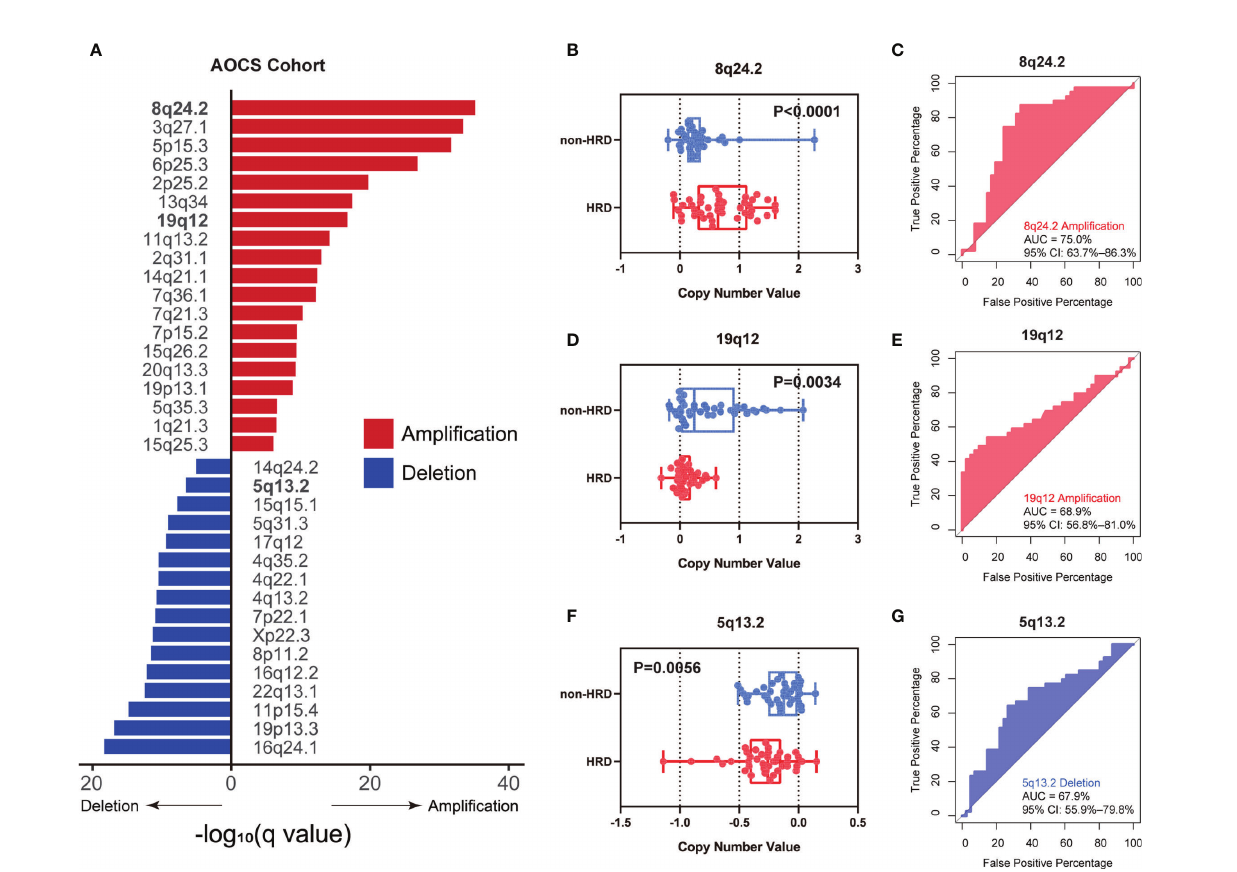
FIGURE 2 | External validation of the CNV biomarkers for HRD status in AOCS. (A) The enrichment level of genome CNVs in all ovarian cancer patients from the AOCS cohort. (B – G) According to BRCA1/2 mutation, BRCA1 promoter methylation, and other HRR gene mutations ( RAD51C , CHEK2 , BRIP1 , and PTEN ), ovarian cancer patients in the AOCS cohort were divided into an HRD group and a non-HRD group. (B, D, F) Differences of copy number value of 8q24.2 (B) , 19q12 (D) , and 5q13.2 (F) calculated by GISTIC between HRD group and non-HRD group. (C, E, G) Performance of 8q24.2 ampli fi cation (C) , 19q12 ampli fi cation (E) , and 5q13.2 deletion (G) in predicting HRD/non-HRD. Statistical analysis was performed by Wilcoxon signed rank test in (B, D, F)